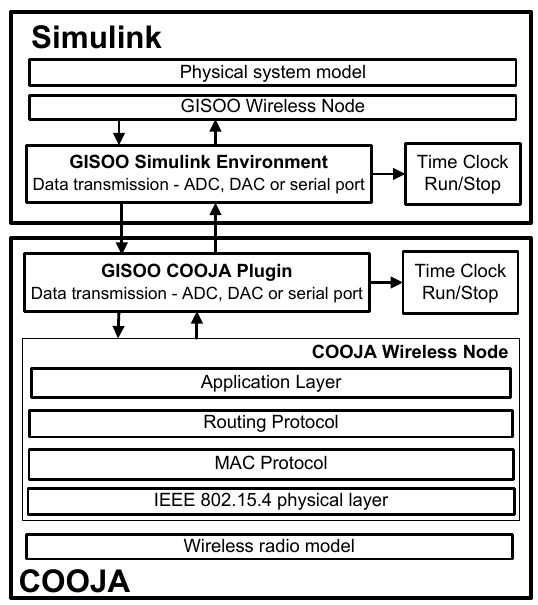
Figure 4. The architecture of